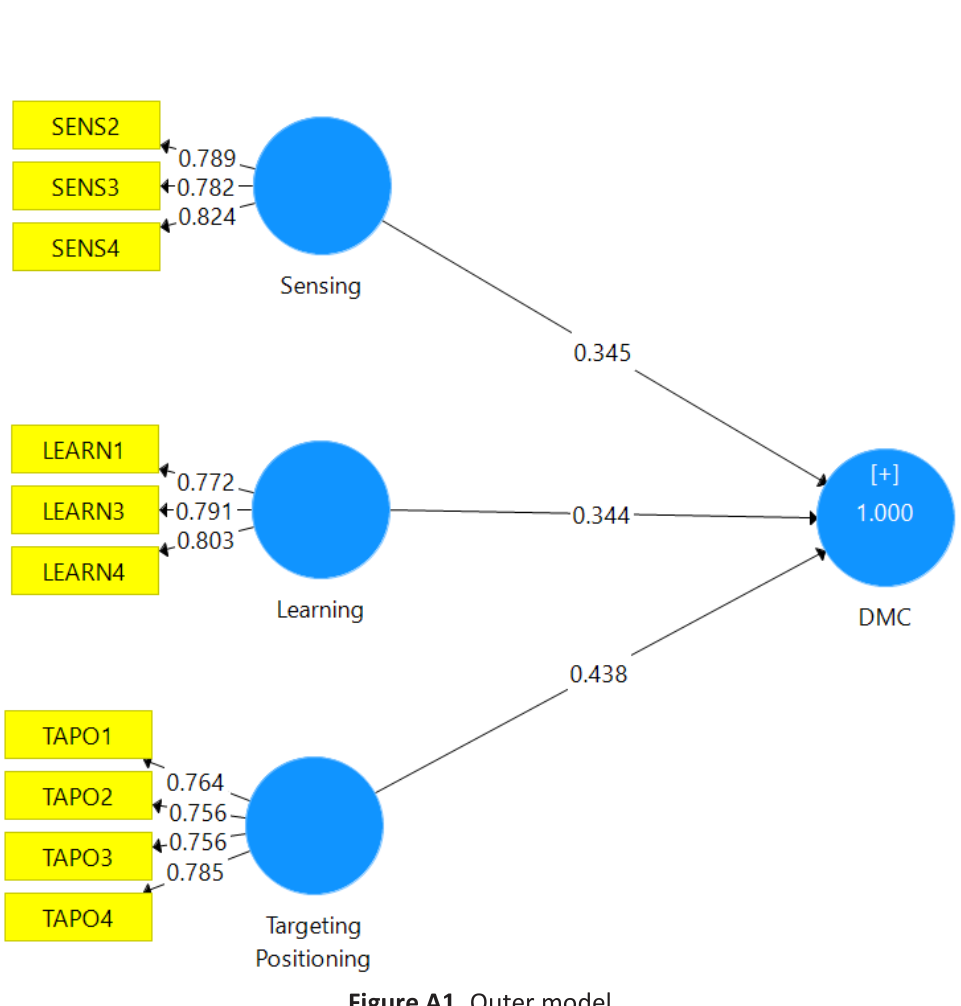
Figure A1. Outer